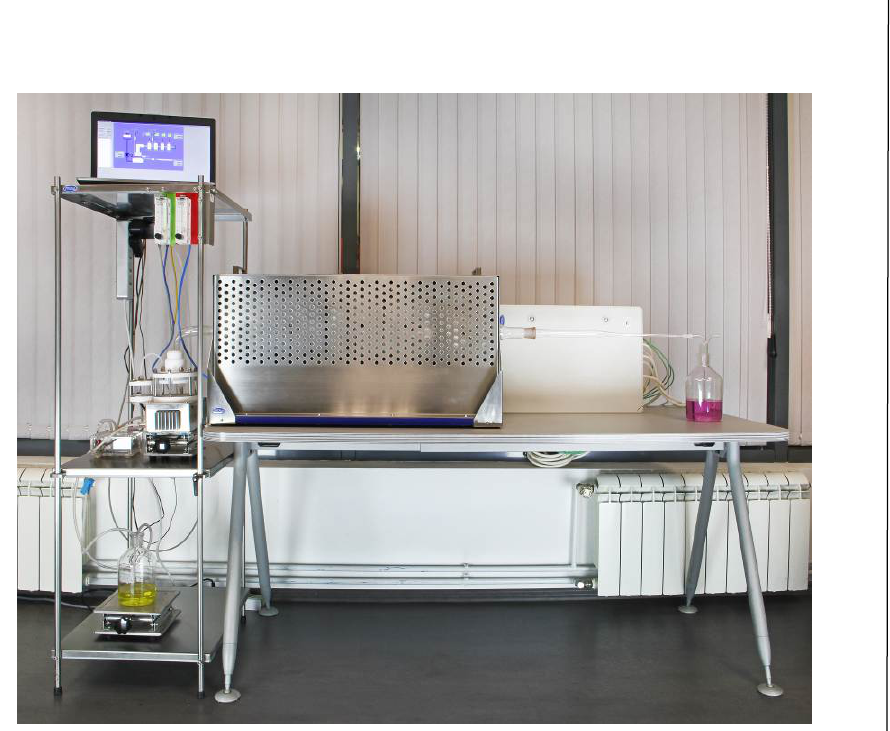
Figure 7 – Improved USP Setup: a bottle with HAuCl 4 solution (yellow color), a peristaltic pump, an ultrasonic atomizer (f=1.7 MHz), an electronic unit with on-line process control, a quartz tube, a horizontal furnace and a bottle with water for the collection of gold nanoparticles (purple color, particle size approx. 50-80